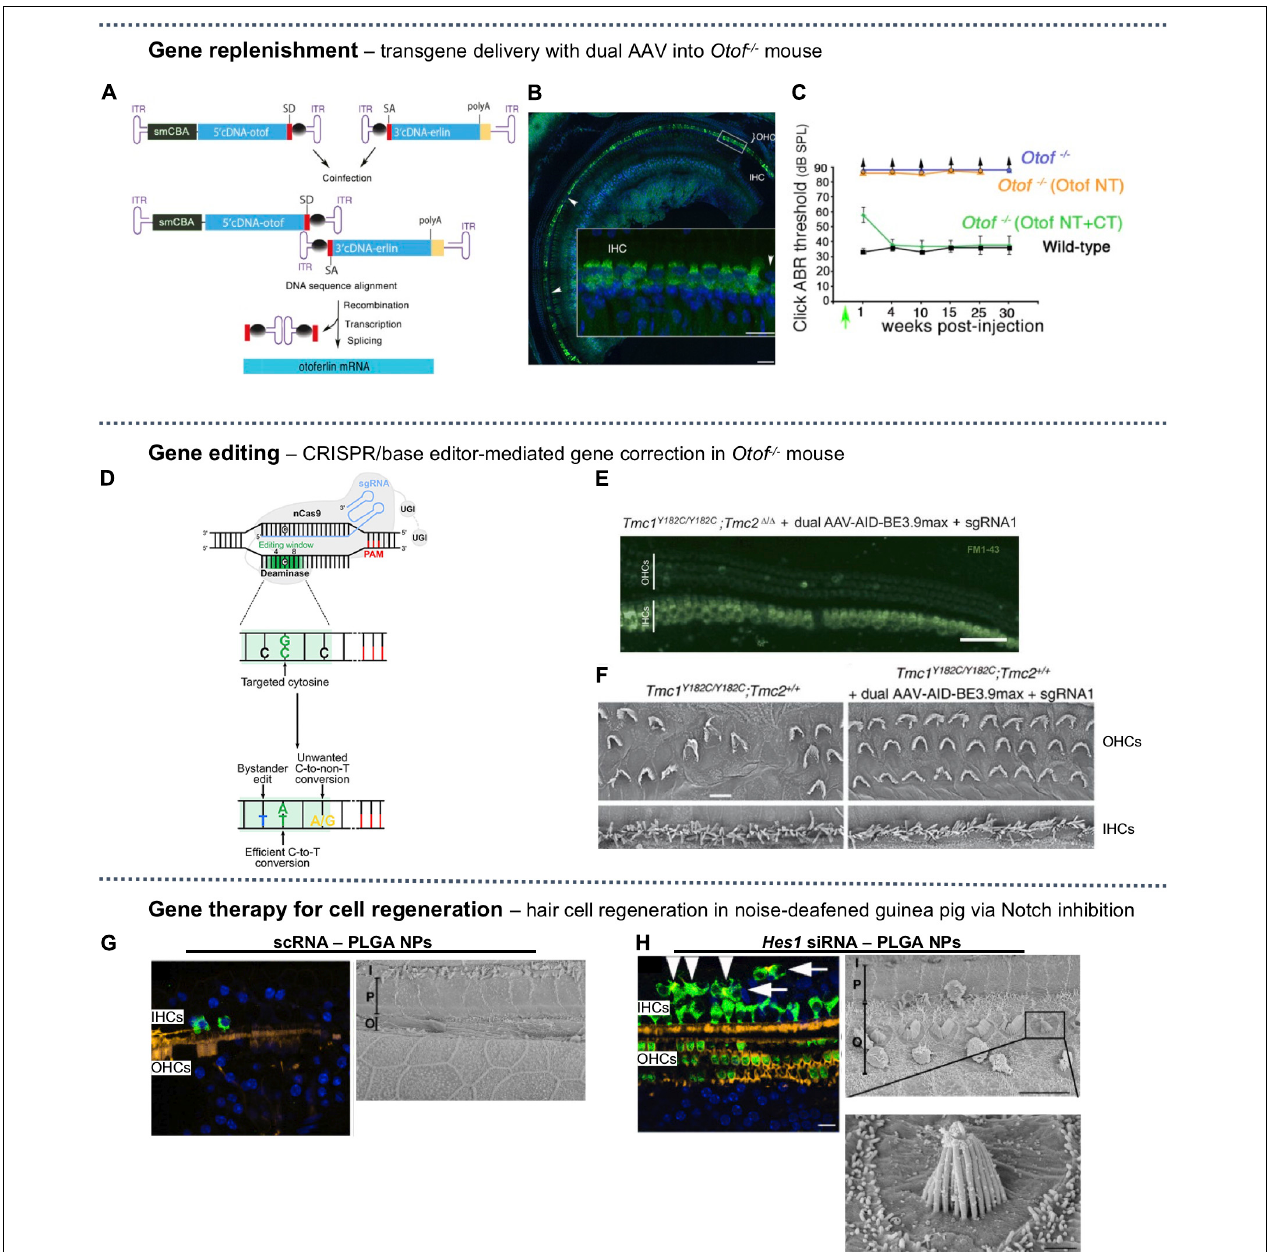
FIGURE 4 | A selection of SNHL gene therapies studied in vivo . (A) Dual AAV-based packaging of the gene encoding Otoferlin, bridged by inverted terminal repeats (ITR). (B) The mid-to-apical turn of injected mouse cochlea showed strong expression of otoferlin (green) in inner hair cells (IHCs) but not in outer hair cells (OHCs), nuclear backstained in blue. (C) Auditory brainstem response (ABR) for dual-AAV injected mice (green) was similar to wild-type (black), but single-AAV injected mice (orange) and untreated mice (blue) had no measurable ABR threshold. The recombinant AAV-Otof NT and AAV-Otof CT vectors contain the 5 (cid:48) and 3 (cid:48) parts of the otoferlin cDNA, respectively. (A–C) Reproduced from Akil et al. (2019), available under Creative Commons license (CC BY-NC-ND 4.0). (D) A cytosine base editor composed of a nickase Cas9 (nCas9) fused to a deaminase can convert C:G base pair to T:A along with bystander edits or unwanted edits. Reproduced from Antoniou et al. (2021), available under Creative Commons license (CC BY 4.0). (E) Confocal images of mid-turn cochlea excised from base editing-treated Baringo mouse showing uptake of FM1-43 (green) in IHCs and OHCs, indicating restored mechanotransduction (scale bar = 50 µ m). (F) Scanning electron microscopy (SEM) images of apical OHCs and IHCs of [left] untreated Baringo mouse and [right] base editing-treated Baringo mice (scale bar = 10 µ m). (E,F) Reproduced from Yeh et al. (2020) with permission. (G) Sham-treated (scRNA) noise-deafened guinea pig [left] mid-turn hair cells immunostained with anti-myosin VIIa (green), stereocilia with phalloidin (yellow), nuclei (blue) (scale bar = 50 µ m) and [right] SEM showing complete ablation of basal OHCs (scale bar = 10 µ m). (H) Noise-deafened guinea pig treated with Hes1 silencing RNA (siRNA) for Notch inhibition [left] immunohistochemical staining showing supernumery IHCs; arrowheads indicate ectopic IHCs with stereocilia, arrows indicated those without (scale bar = 50 µ m) and [right] SEM showing regenerated basal OHCs, some with abnormal stereocilia lacking the canonical stair-step organization (scale bars = 10 µ m and 1 µ m). (G,H) Reproduced from Du et al. (2018), available under (CC BY-NC-ND